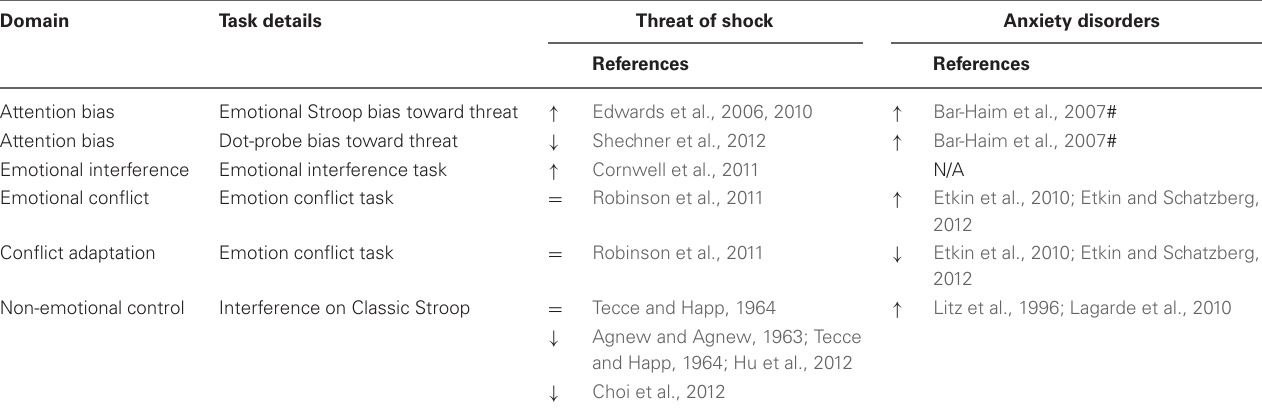
Table 3 | Effects of anxiety on attentional bias and attention control tasks (arrows represent direction of effect).